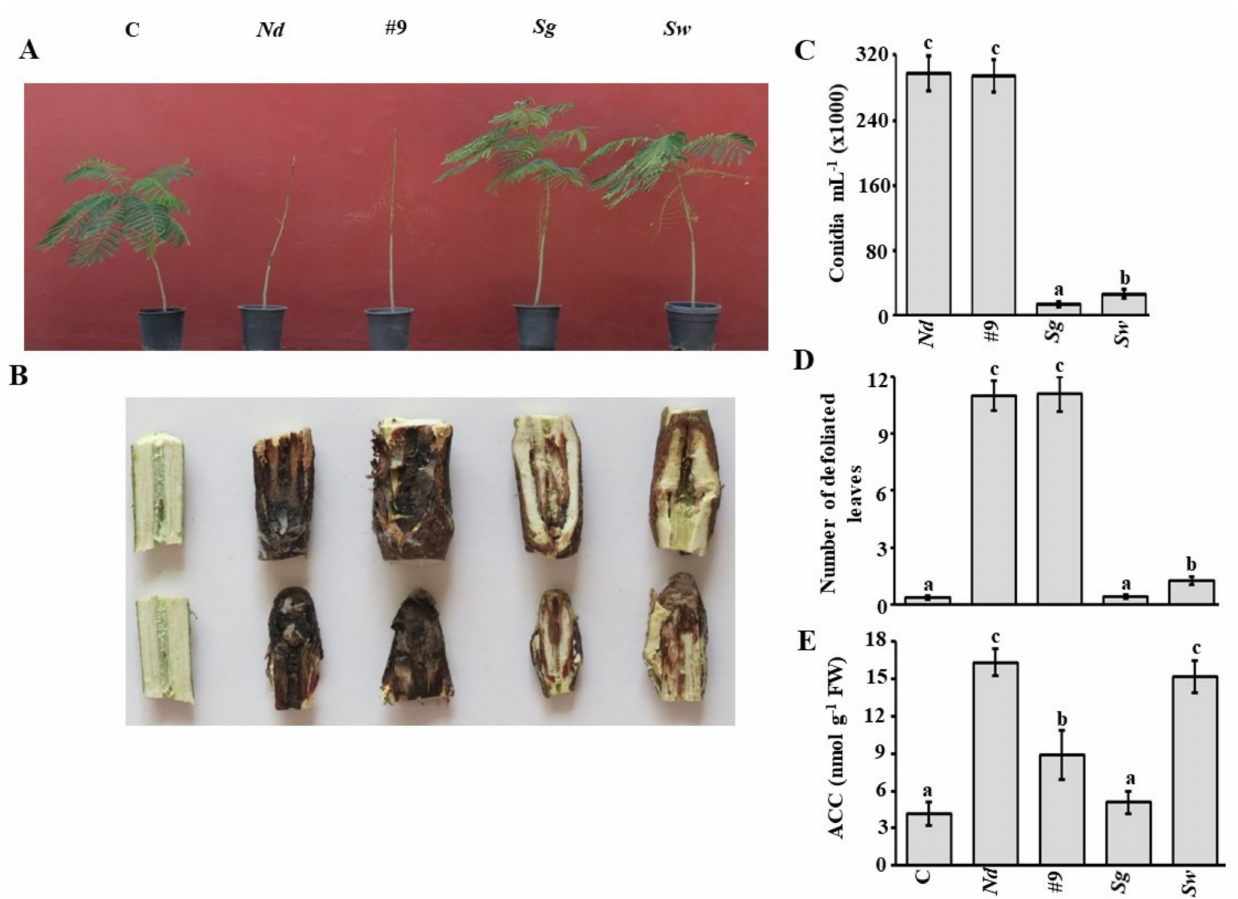
Figure 5. Effect of biocontrol application on inoculated-royal poinciana inoculated with Neoscytalidium dimidiatum . Effect of the preventive ( A ) BCA treatment; and ( B ) symptoms of inoculated regions with N. dimidiatum . Number of ( C ) conidia after the pathogen recovery from affected stem tissues; ( D ) defoliated leaves; and ( E ) endogenous contents of ACC in stem tissues of inoculated royal poinciana seedlings after BCA treatment after 10 wpt growing under container nursery conditions. In ( C – E ), values with different letters are significantly different from each other at p < 0.05. Bars represent standard errors. C, non-inoculated control seedlings, Nd , seedlings inoculated with N. dimidiatum only; #9/ Sg / Sw , seedlings inoculated with the individual isolate two weeks prior to N. dimidiatum inoculation. #9, non-antifungal-, non-CWDE- and ACCD-producing isolate #9 (control); Sg, ACCD-producing Streptomyces griseorubens UAE2 (BCA3; isolate #21); Sw, ACCD-non-producing Streptomyces wuyuanensis UAE1 (BCA5; isolate #45); FW, fresh weight; ACC, 1-aminocyclopropane-1-carboxylic; ACCD, ACC deaminase; Nd, N. dimidiatum ; BCA, biological control agent; wpt, weeks post